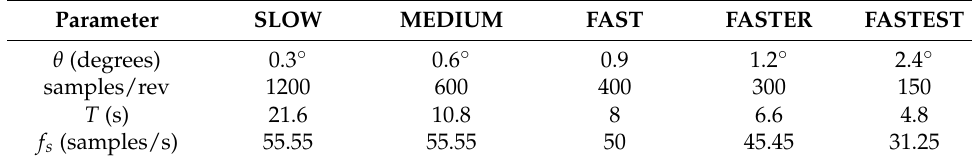
Table 2. Imagenex Parameters for the Range of 10 m. Parameter